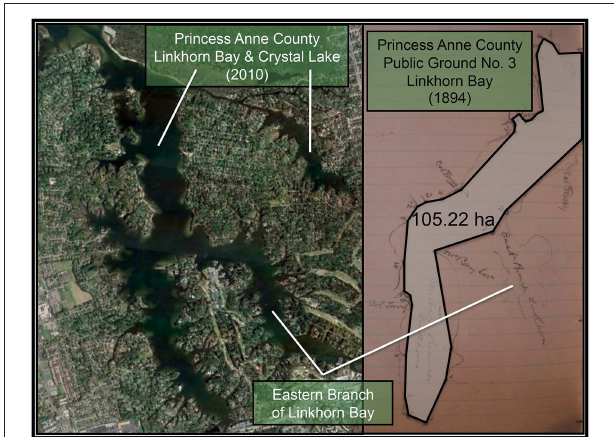
FIGURE 4 | (Right) Photograph of the sketch by Baylor (1893) for Public Ground No. 3 (Linkhorn Bay) in Princess Anne County, with a polygon connecting the points of the oyster ground superimposed on the photograph. The shoreline of Linkhorn Bay is faintly visible bordering the polygon. (Left) Recent satellite image of Linkhorn Bay and Crystal Lake, at approximately the same scale as the sketch, adapted from Google Earth.